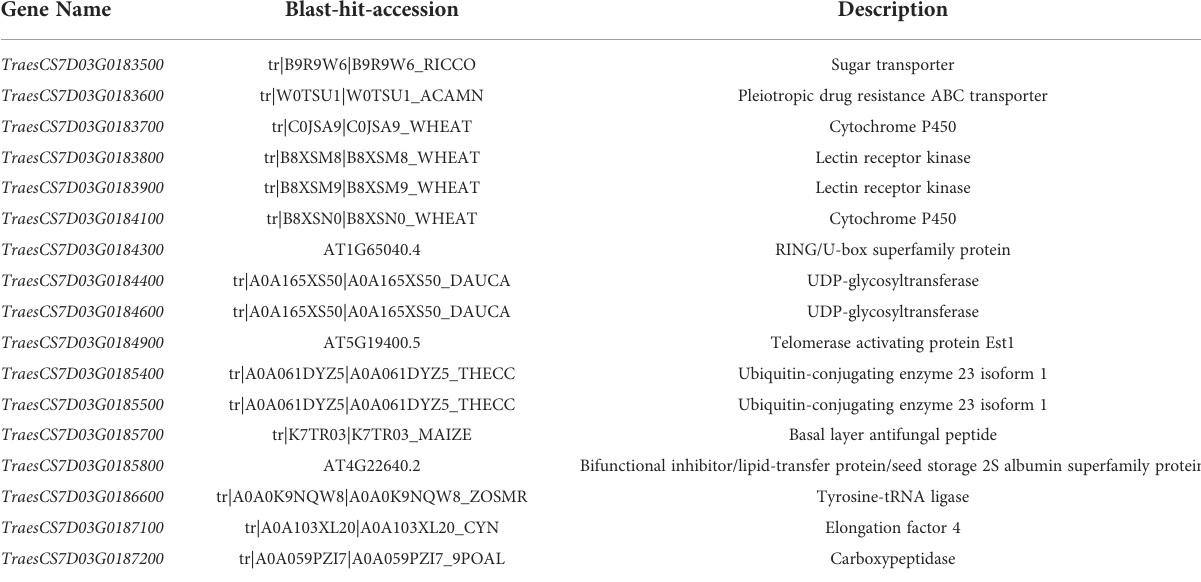
TABLE 3 Candidate genes identi fi ed for QTL QPm.cas-7D with putative functions of interest and their functional